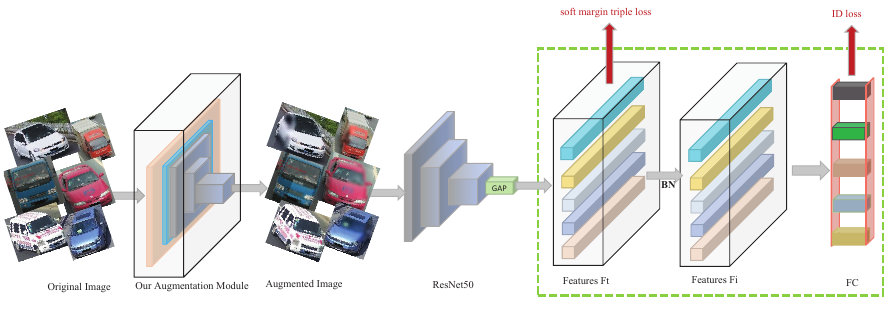
Figure 6. Overview of baseline